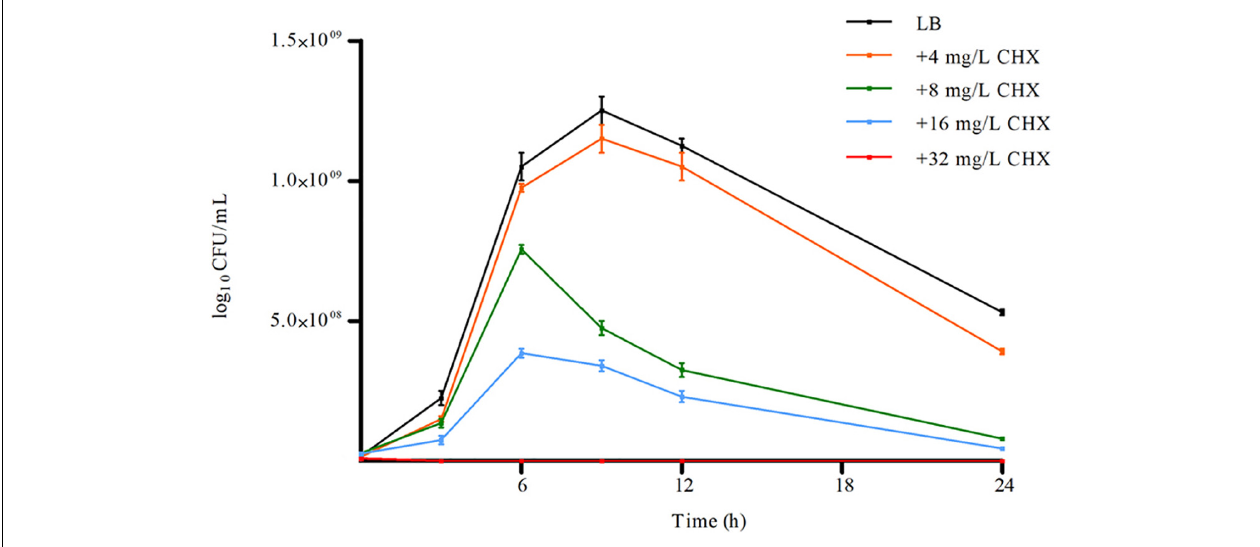
FIGURE 1 | Effect of increasing concentration of CHX on A. baumannii ATCC 19606 planktonic growth. Error bars represent standard deviations based on three independent experiments. CFU, colony-forming units.